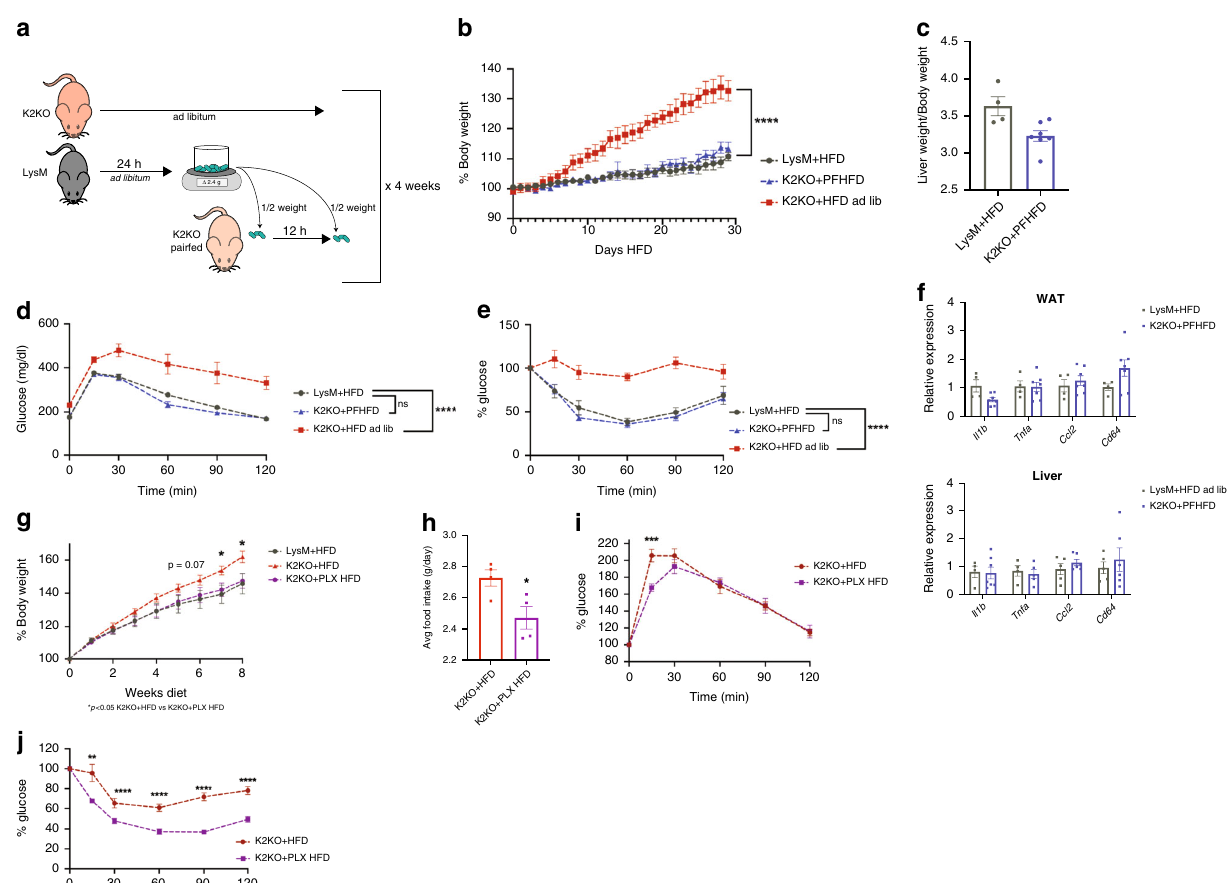
Fig. 4 Loss of myeloid KLF2 affects centrally-governed food intake and metabolic disease. a Schematic describing pair-feeding protocol. b Pair-feeding K2KO mice (K2KO + PFHFD) abrogates weight gain compared to K2KO mice fed HFD ad libitum, LysM and K2KO ad lib. n = 4, K2KO PFHFD n = 7, **** p < 0.0001 comparing K2KO PFHFD to K2KO HFD by repeated measures one-way ANOVA with Tukey ’ s multiple comparison test. c Pair-feeding attenuates K2KO hepatomegaly, LysM n = 4, K2KO PFHFD n = 7. d Intraperitoneal glucose tolerance test (IPGTT) demonstrates improved glucose sensitivity in one month K2KO PFHFD mice, LysM and K2KO ad lib. n = 4, K2KO PFHFD n = 7, **** p < 0.0001 comparing K2KO PFHFD to K2KO HFD by repeated measures one-way ANOVA with Tukey ’ s multiple comparison test. e Intraperitoneal insulin tolerance test (IPITT) demonstrates improved insulin sensitivity in one month K2KO PFHFD mice, LysM and K2KO ad lib. n = 4, K2KO PFHFD n = 7, **** p < 0.0001 comparing K2KO PFHFD to K2KO HFD by repeated measures one-way ANOVA with Tukey ’ s multiple comparison test. f Pair-feeding K2KO mice rescues in fl ammatory gene transcription in WAT and liver, LysM and K2KO ad lib. n = 4, K2KO PFHFD n = 7. g Microglial ablated K2KO mice on HFD (using PLX5622 formulated HFD, PLX HFD) demonstrate improved weight gain over 8 weeks, LysM n = 7, K2KO + HFD and K2KO + PLXHFD n = 12, 7 weeks p = 0.0153, 8 weeks p = 0.0015 comparing K2KO + HFD to K2KO + PLX HFD. h Two months K2KO PLX HFD-fed mice consume less food than K2KO HFD mice, n = 4, p = 0.0284. i IPGTT demonstrates rescued glucose tolerance in K2KO PLX HFD mice, n = 12, p = 0.0042 at 15 min. j IPITT demonstrates rescued insulin sensitivity in K2KO PLX HFD mice, n = 12, p = 0.0482 (15 min), 0.0371 (30 min), 0.0003 (60 min), <0.0001 (90 min), 0.0001 (120 min) by unpaired two-tailed Student ’ s t -test, comparisons marked or indicated in fi gure legend. Error bars represent SEM. Pair-feeding experiments and associated metabolic parameters were performed for/at 1 month. PLX HFD metabolic parameters were performed at 1 month unless otherwise indicated. n represents biologically independent mice throughout entire fi gure. Source data are provided as a Source Data fi cells, controlling food intake is suf fi cient to protect against per-